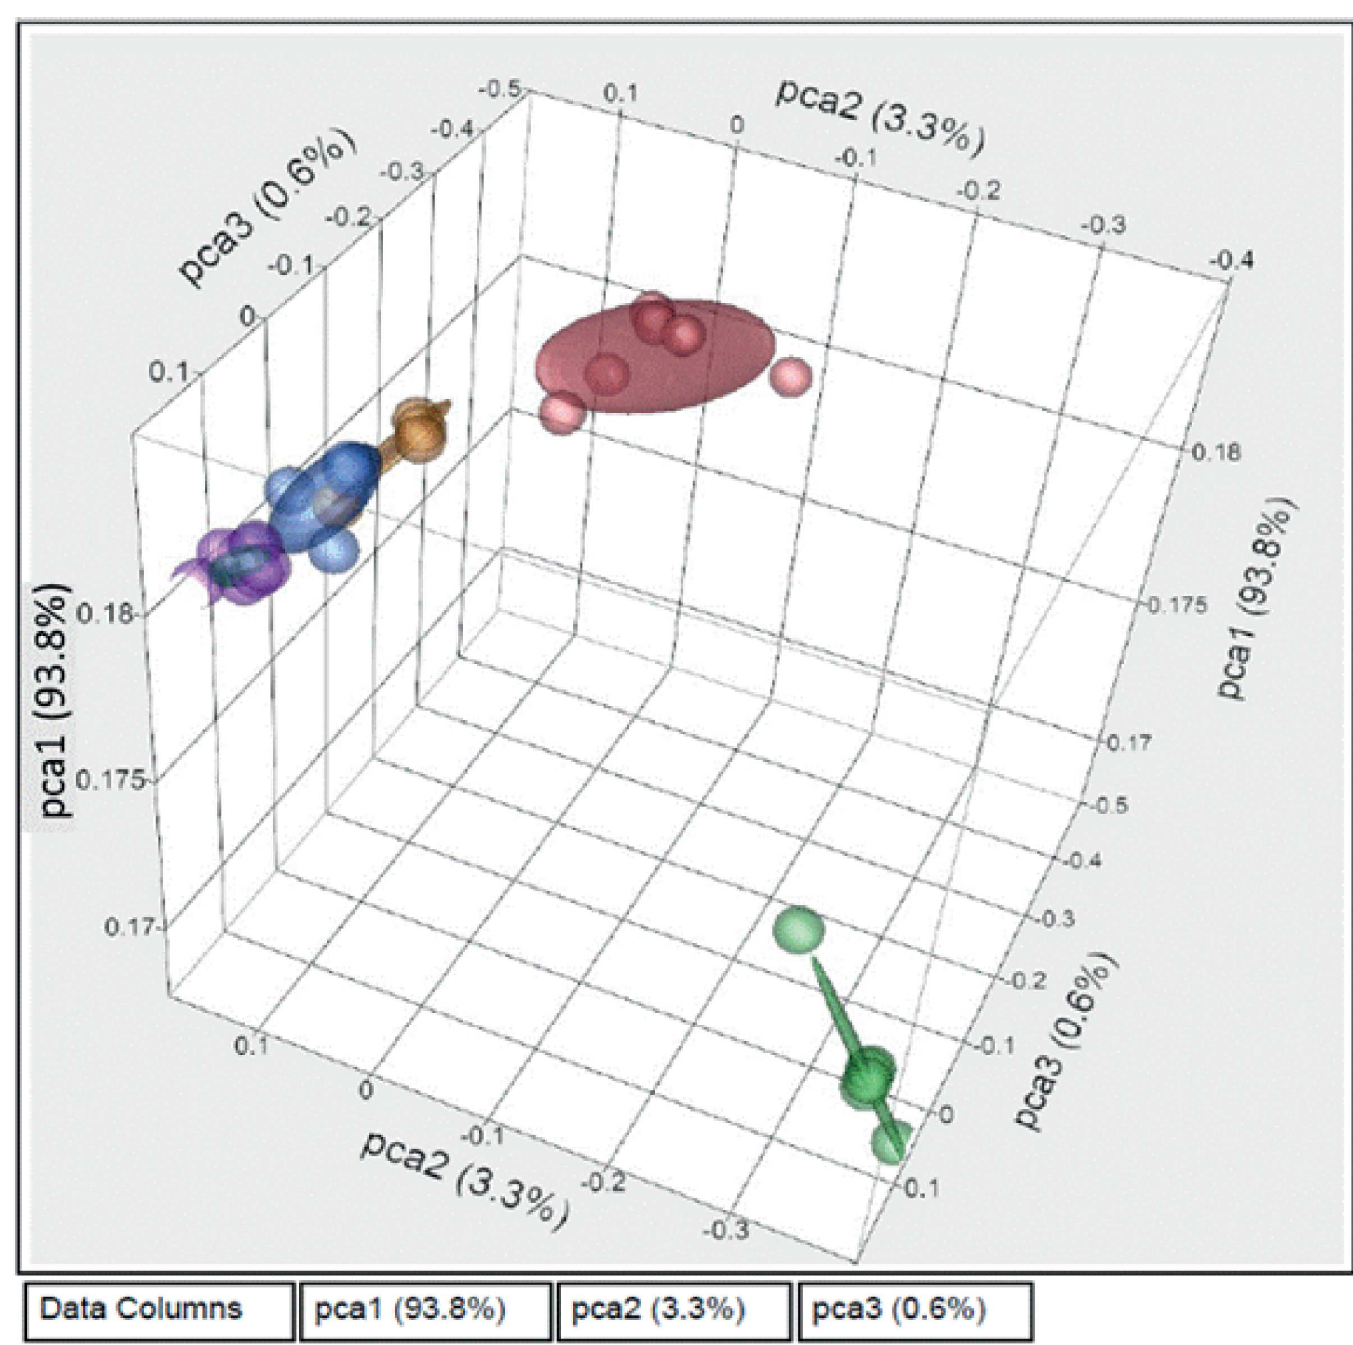
Fig 6. A 3D Principal Component Analysis of male rainbow darter gene expression profiles in gonad tissue across the annual cycle. Different colors represent the different stages of gonad maturity, including post-spawning (green at bottom right), recrudescence (yellowto the right of the cluster at top left), developing (red top right), pre-spawning (blue in the centre of the cluster at top left) and spawning(purpletop